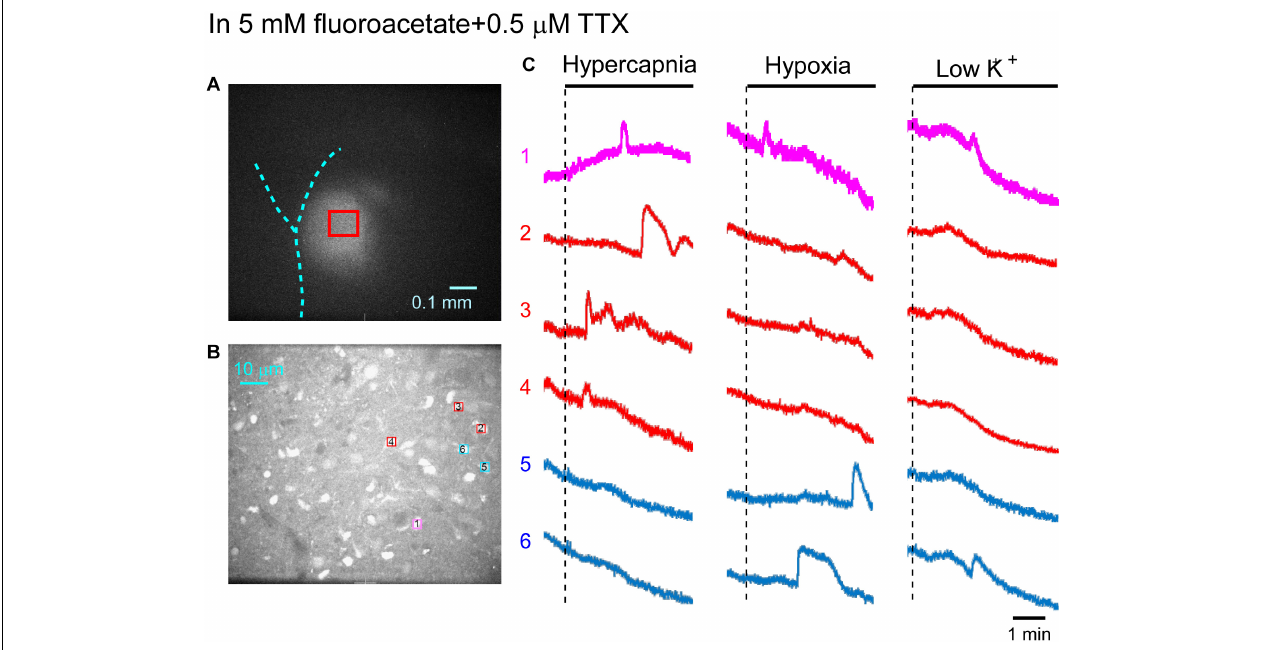
FIGURE 5 | Calcium imaging in the NTS in fluoroacetate plus TTX solution. (A) Low-magnification image of the cut surface where Oregon Green was injected and calcium imaging was performed. (B) Optical image of the cut surface stained with Oregon Green. The red square in (A) corresponds to measured area in (B) . (C) Calcium signals plotted as fluorescence intensity in identified NTS cells numbered in the image in (B) in response to hypercapnia (left), hypoxia (middle) and low K + (right) stimulation. Magenta trace denotes calcium signal intensity of cells (No. 1) responding to stimulation of both hypercapnia and hypoxia. Red traces denote calcium signal intensity of cells (Nos. 2–4) responding only to hypercapnia. Blue traces denote calcium signal intensity of cells (Nos. 5 and 6) responding only to hypoxia.